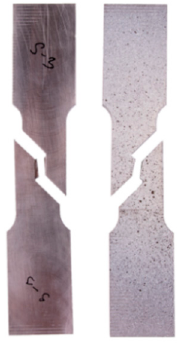
Figure 7. Notched tensile test specimens.